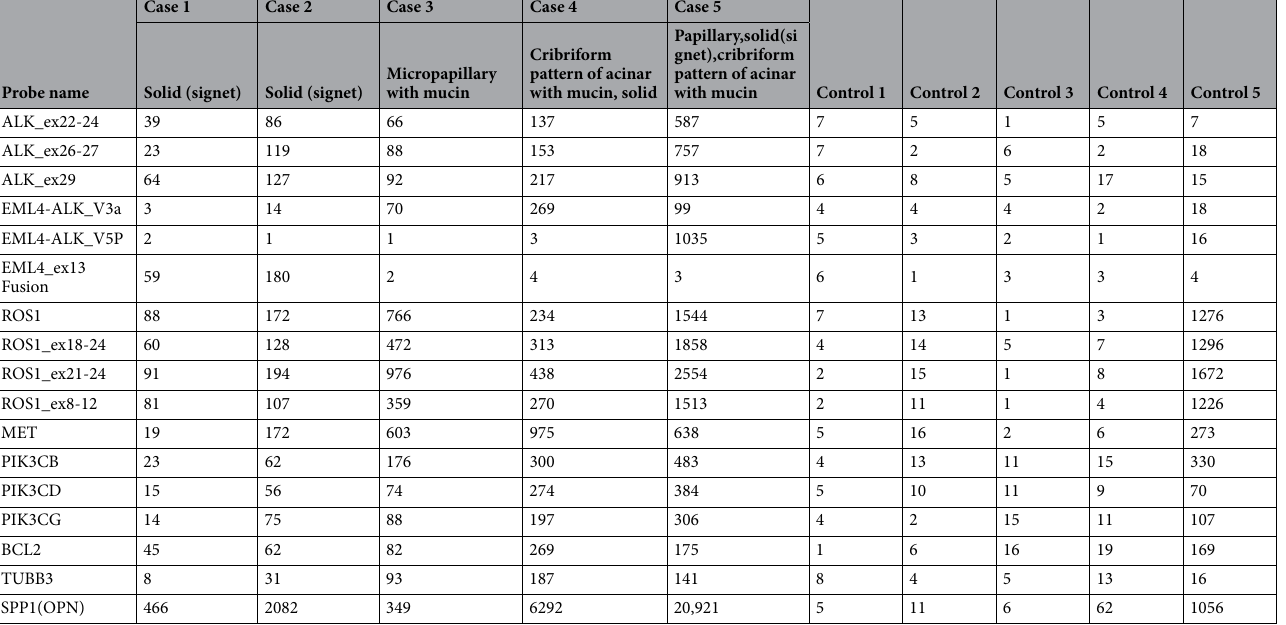
Table 5. Gene counts of 5 ALK-positive lung cancer cases and the corresponding pericarcinous tissues by NanoString